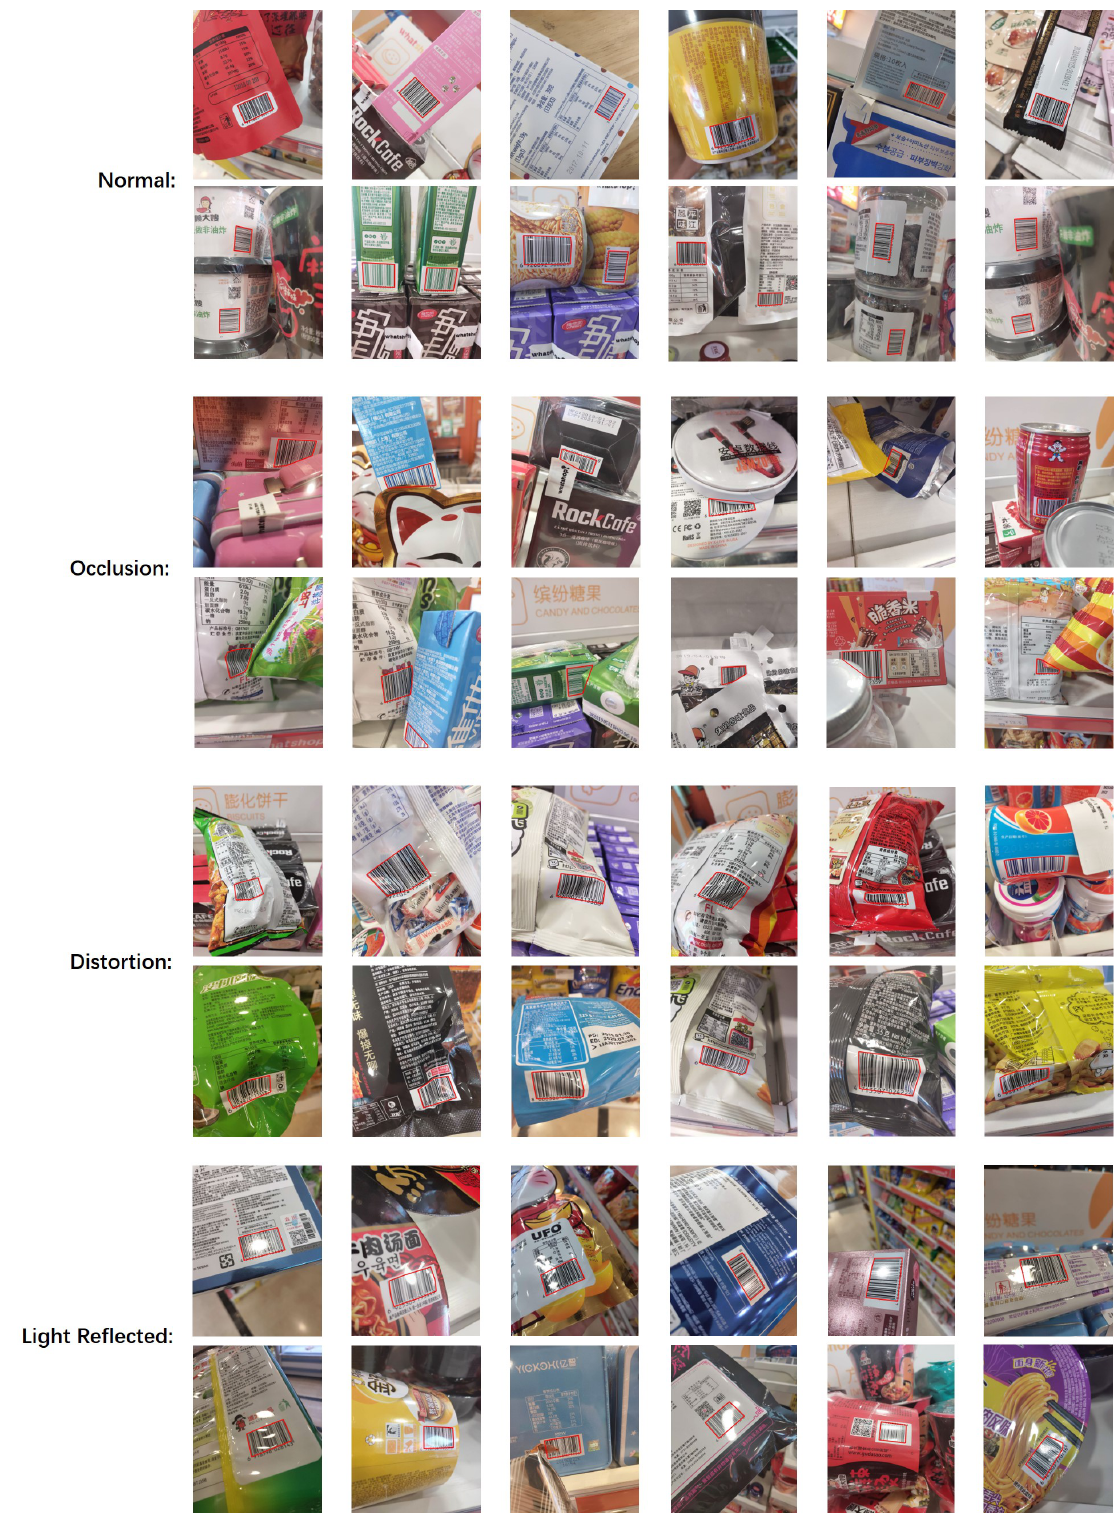
Figure 8. Some examples in different conditions: normal, occlusion, distortion, and light